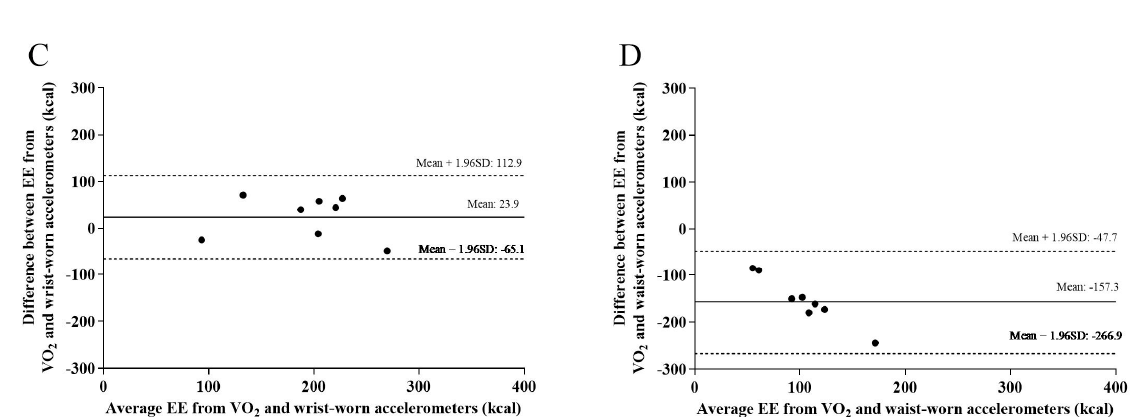
Figure 1. Bland–Altman plots: Differences in average values of energy expenditure (EE) from oxygen consumption (VO 2 ) and either heart rate (HR) models ( A , B ) or accelerometers ( C , D ). Mean difference and 95% limits of agreement (mean ± 1.96 SD) are also displayed.